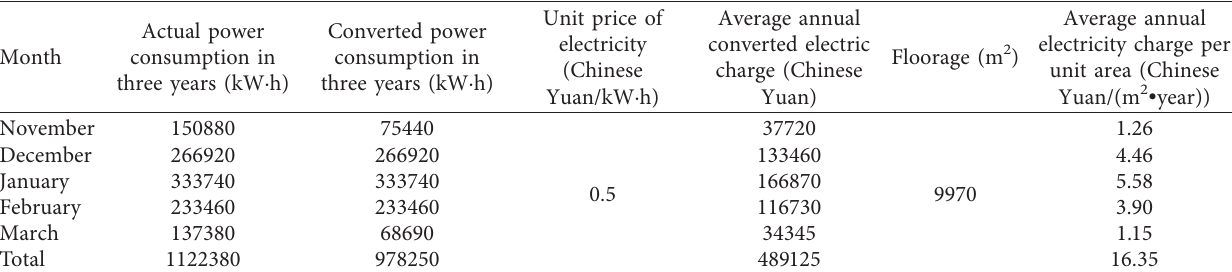
Table 8: Converted operating cost of heat pump system.